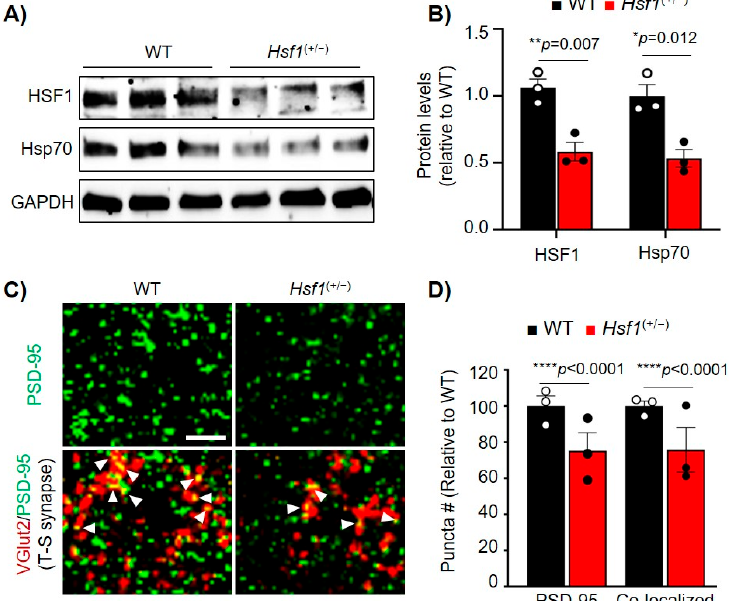
Figure 3. HSF1 haploinsufficiency decreased PSD-95 puncta and striatal synapse density. ( A ) Im- munoblot from striatum samples of WT ( Hsf1 (+/+) ) and Hsf1 (+/ − ) mice at 2.5 months. GAPDH is used as a loading control. ( B ) HSF1 and Hsp70 Protein levels quantified from ( A ) using ImageJ analyses. Data was normalized to GAPDH levels and relativized to WT. ( C) Immunohistochemistry for PSD- 95 (green) and the pre-synaptic vesicular protein VGlut2 (red) in the striatum of WT and Hsf1 (+/ − ) at 12 months. Arrows indicate co-localization between PSD-95 and VGlut2. Scale bar 5 µm. ( D ) Puncta analysis for PSD-95 and co-localized PSD-95/VGlut2 from (C). Punta number (#) was relativized to WT. Error bars denote mean ± SEM. n =3 mice/genotype. Unpaired Student’s t test. * p < 0.05, ** p < 0.01, *** p < 0.001, **** p < 0.0001. Uncropped blots can be found in Supplementary Materials (Sup-